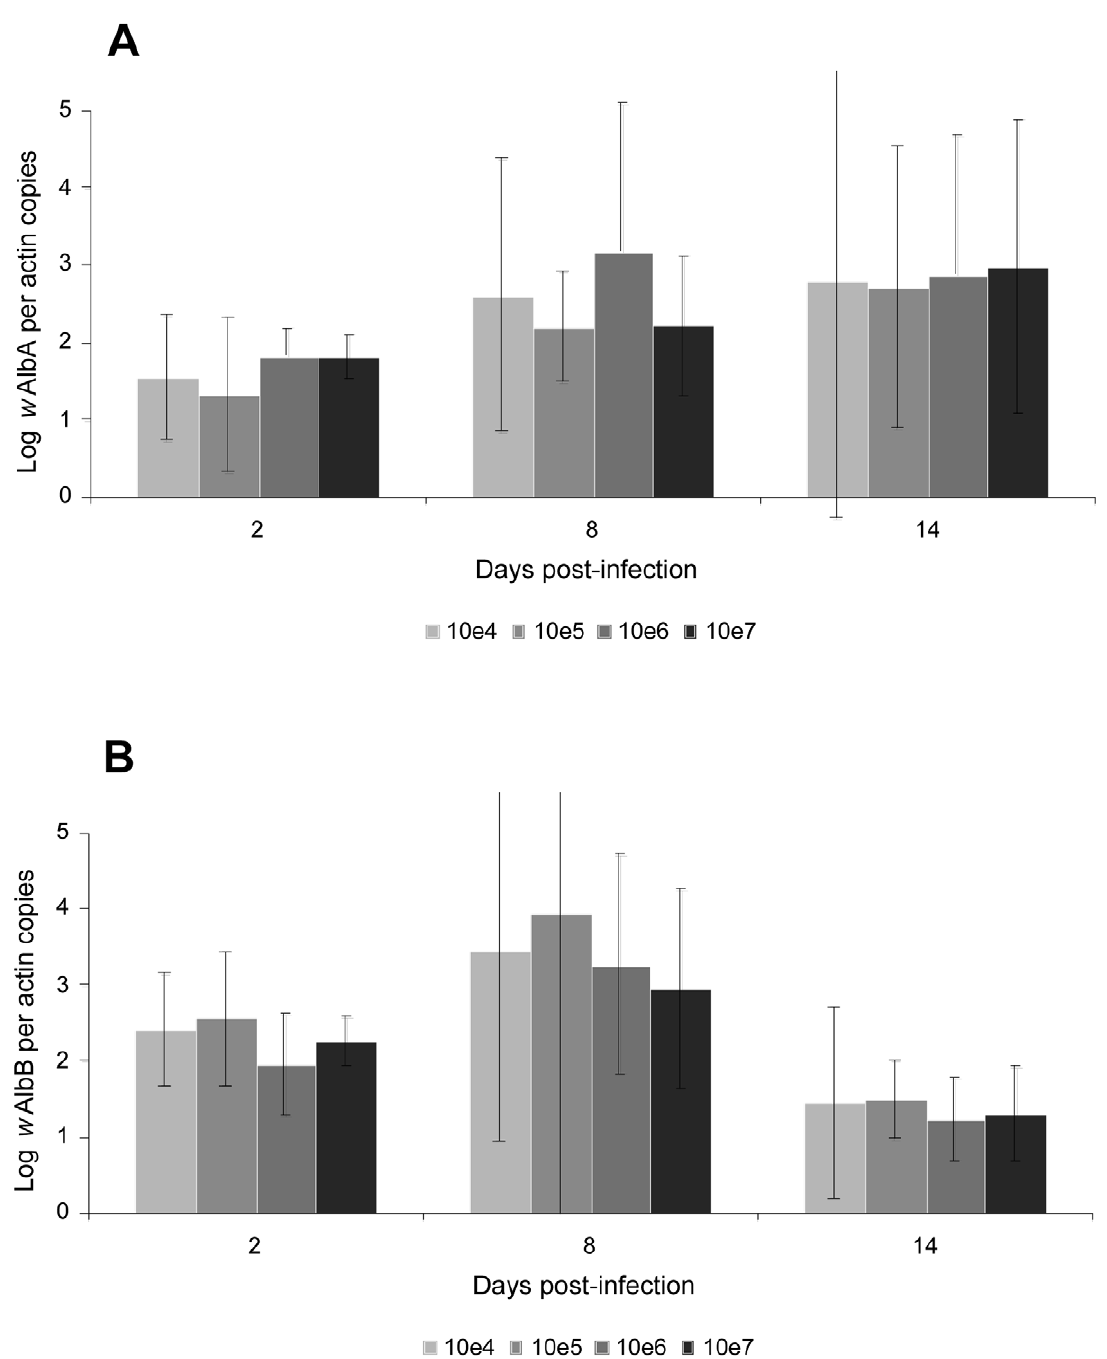
Figure 3. Wolbachia densities in Ae.albopictus after a DENV-2 blood-meal provided at different titers. At days 2, 8 and 14 pi, 4–9 mosquitoes were individually used for DNA extraction. q-PCR was conducted using primers targeting the w AlbA (A) and w AlbB (B) genes. The Wolbachia copy number was normalized with the Ae. albopictus actin gene. A plasmid (pQuantAlb) containing the three loci w AlbA, w AlbB, and the Ae. albopictus actin gene was serially diluted to build standard curves. Error bars represent standard errors.